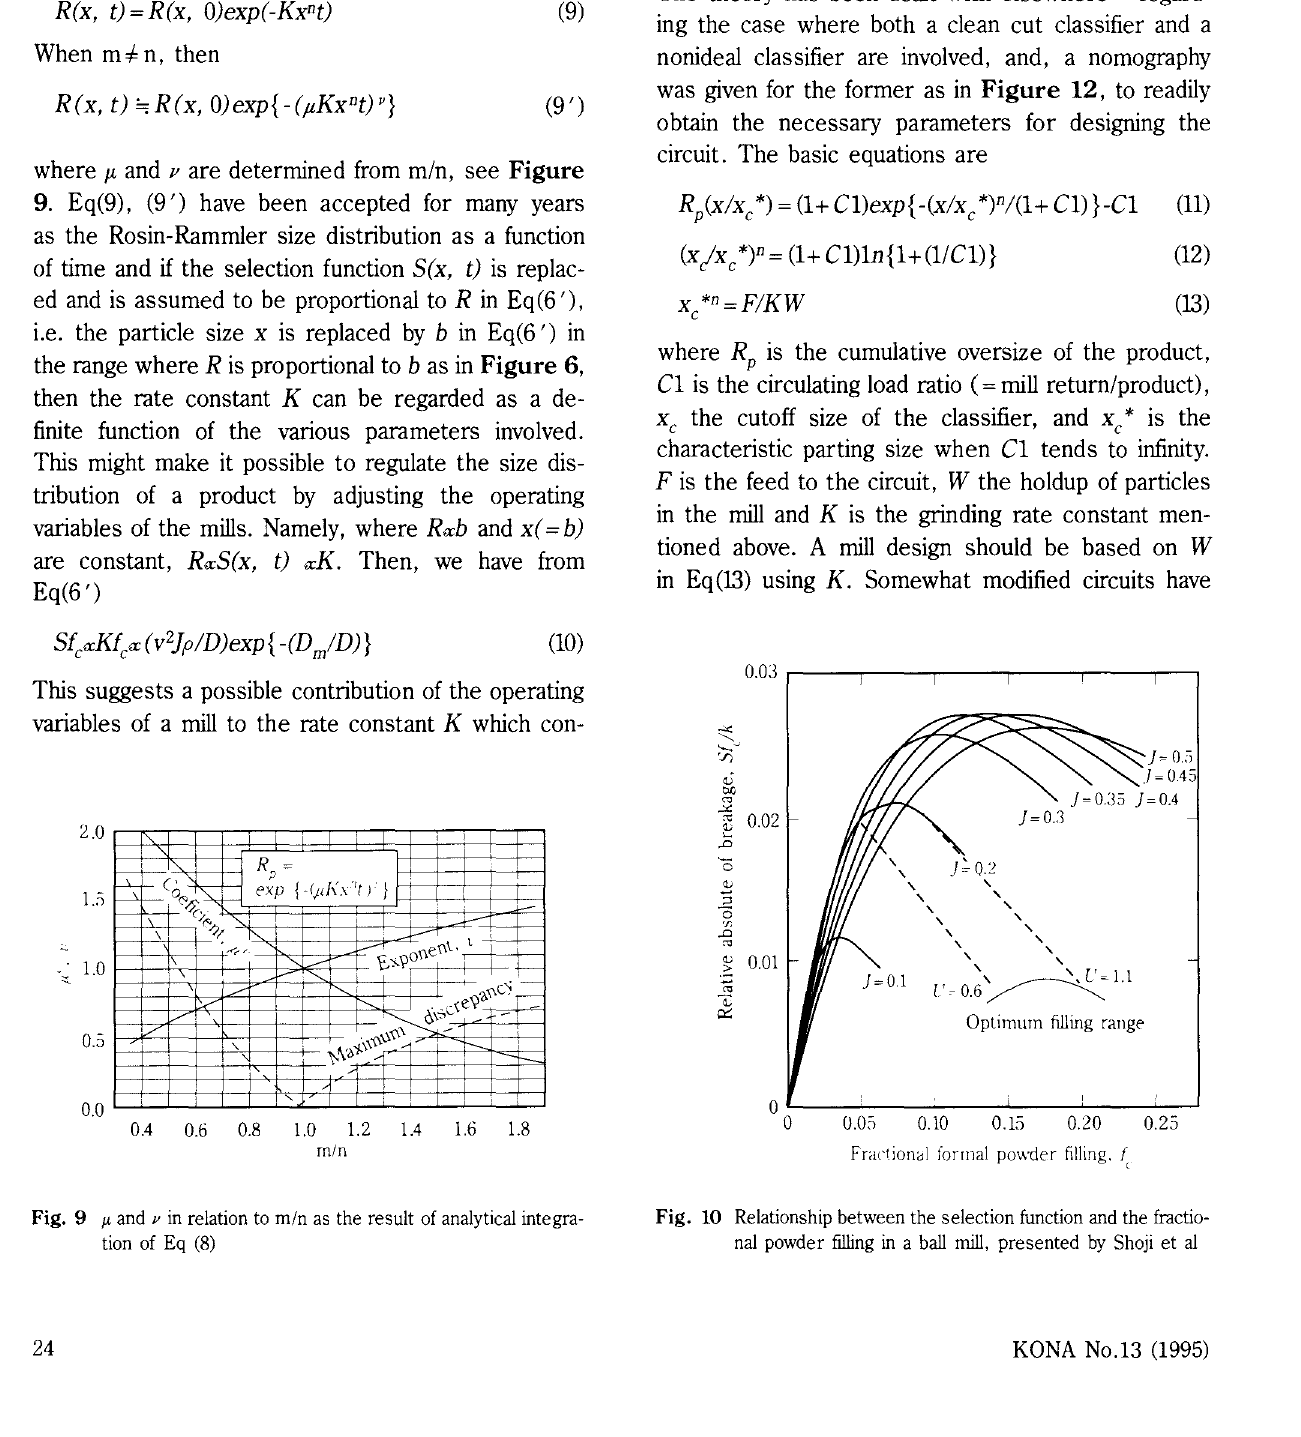
Fig. 9 Jl and v in relation to min as the result of analytical integra tion of Eq (8)